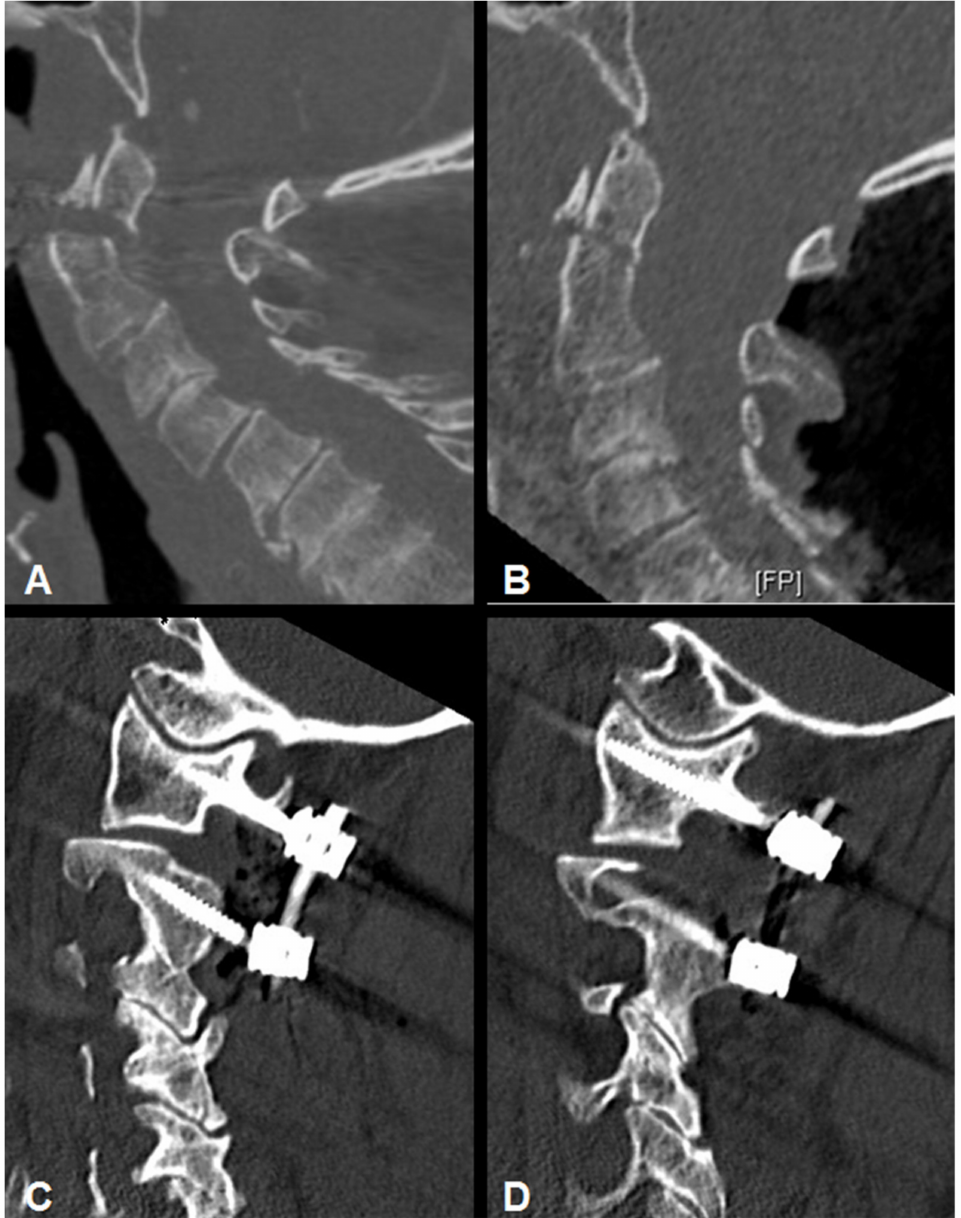
Figure 2. ( A ) Sagittal CT-image of a 91-year old male with an unstable odontoid type II fracture. ( B ) Intraoperative Sagittal CT data set for spinal navigation showed complete fracture reduction. Postoperative sagittal CT reconstruction after atlanto-axial stabilization using the posterior arch C1 lateral mass (PALM) technique ( C , D